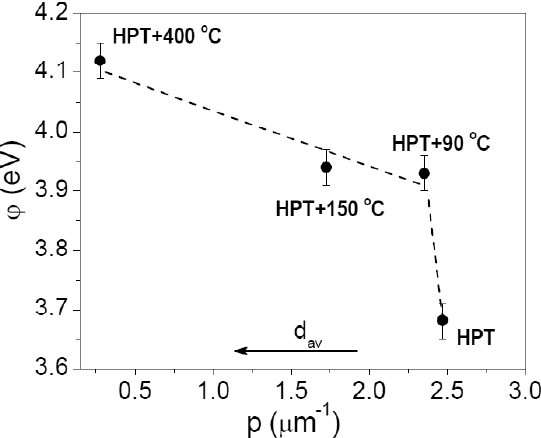
Fig. 2. Dependence of the electron work function on the specific length of grain boundaries for Al sam- ples subjected to HPT processing and subsequent annealing for 1 h at various temperatures.